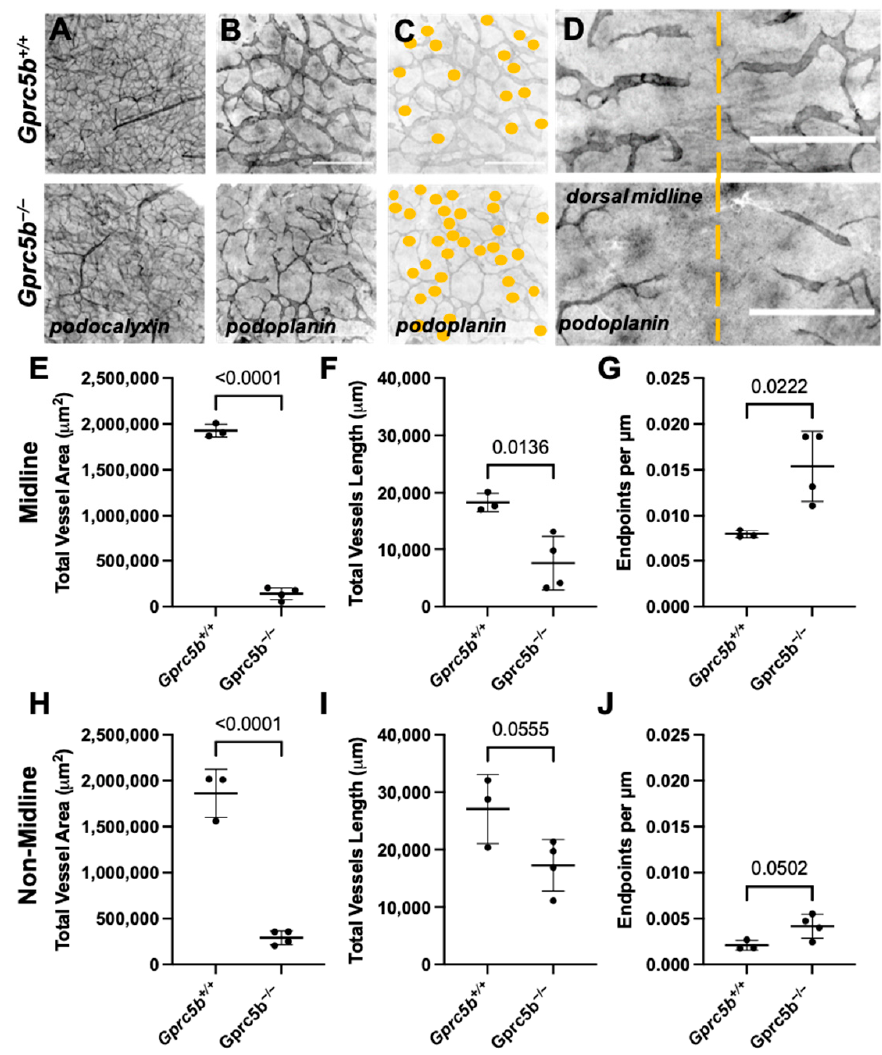
lymphangiogenic fronts near the dorsal midline of Gprc5b +/+ mice (Figure 4D, top panel). However, the growth and migration of dorsal lymphatics towards the midline was severely blunted by genetic loss of Gprc5b (Figure 4D, bottom panel, Figure 4D–G). The impaired lymphangiogenesis was also observed in non-midline dermal lymphatic vessels, which demonstrated reduced total lymphatic vessel area, length and endpoints per µ m lymphatic vessel (Figure 4H–J).